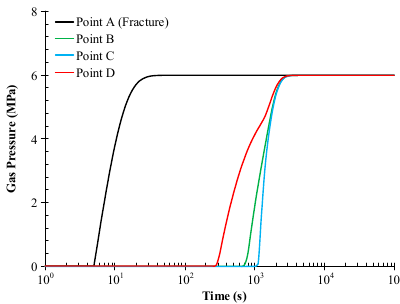
Figure 5. Temporal evolution of pore pressure at four representative points in the matrix.